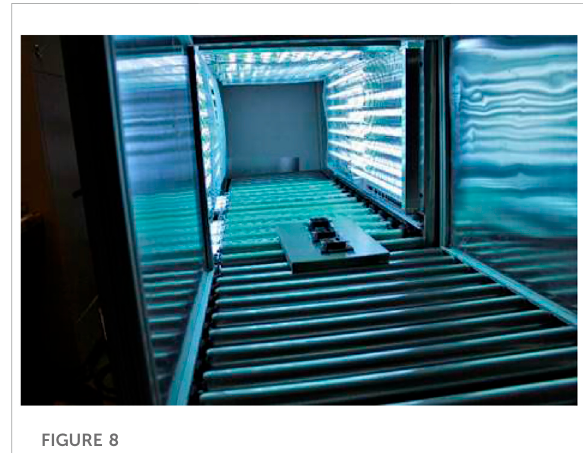
FIGURE 8 Dosimeters traveling down conveyor to determine exposure times for target UV